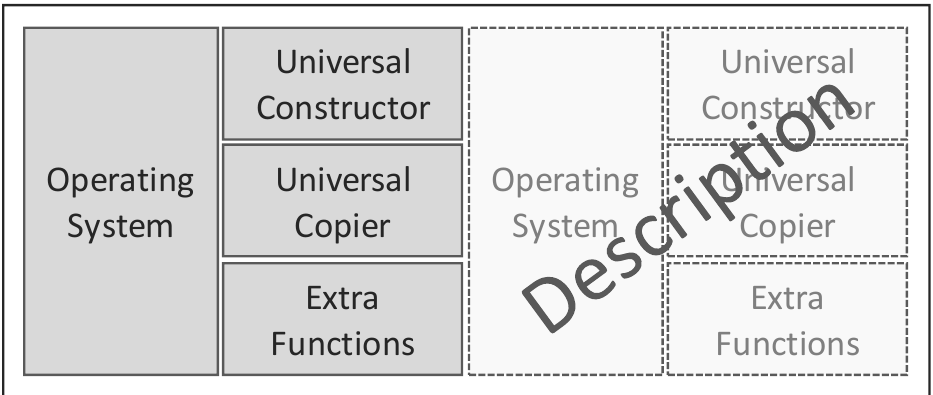
Figure 8. John von Neumann’s system of self-replicating